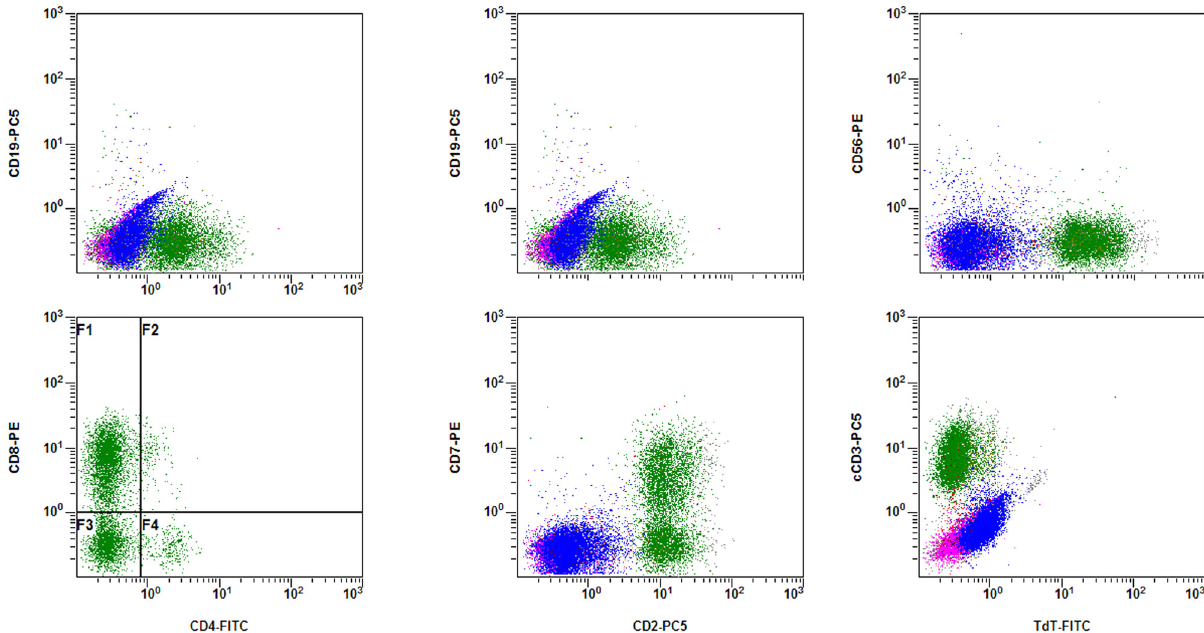
Figure 2: FCM results showing positive CD2, CD3, CD4, CD5, CD7 and CD8 immunoreactivity in BM cells of case